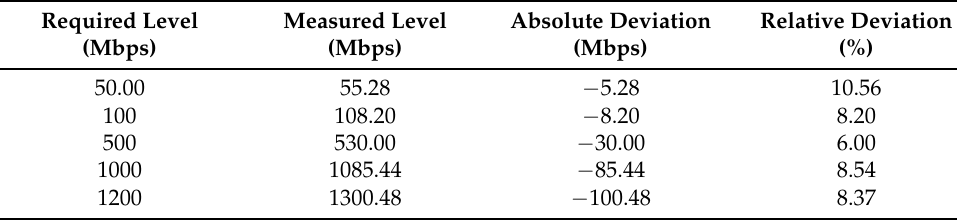
Table 4. Results of measurement of bandwidth.